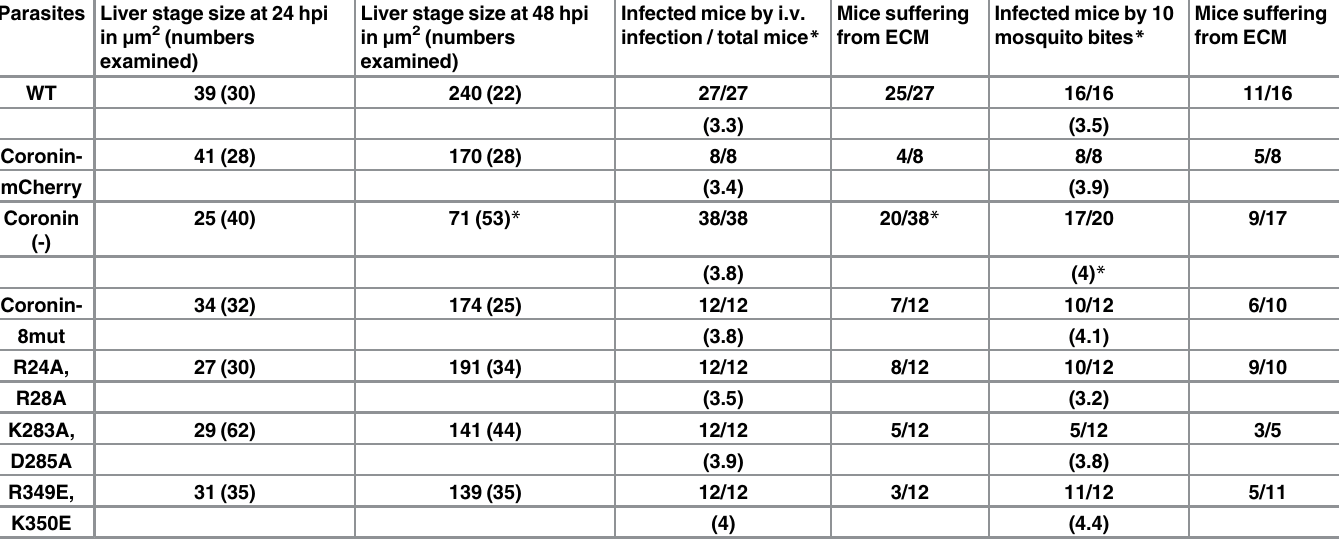
Table 2. Comparison of the different parasite strains for their growth within cultured liver cells and their infectivity for mice. Note that all parasites with a lowered number of sporozoites in their salivary glands (all but WT and coronin-mCherry) failed to infect all mice following mosquito bites. While 100% (24 out of 24) of the mice bitten by mosquitoes infected with either wild type or coronin-mCherry expressing parasites were infected, only 78% (53 out of 68) of the mice bitten by mosquitoes infected with the various mutants developed a blood stage infection. As the motility was similar between WT, coronin- mCherry and the R24A/R28A mutant on one hand and between all the other mutants on the other hand (Table 1), we further analyzed the time to infection of mice successfully infected by mosquitoes. Hence, the first group showed an average time to blood stage infection of 3.4 days and the second group of 3.9 days for i.v. injected parasites (p < 0.001, one way ANOVA) and 3.5 versus 4.1 days (p < 0.01, one way ANOVA) for mice receiving parasites by mosquito